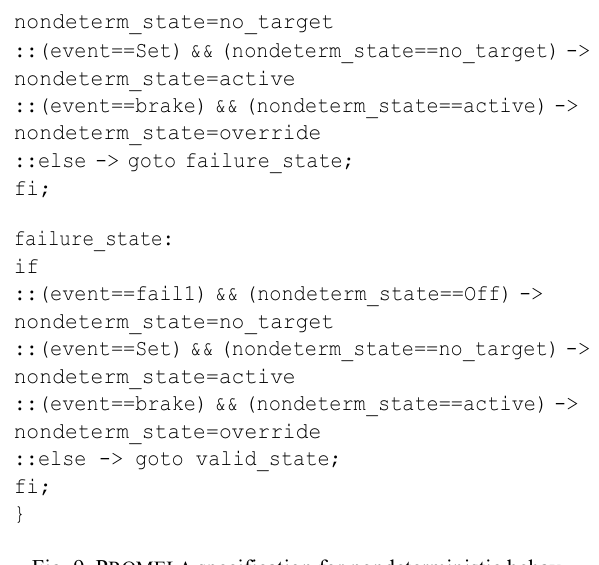
Fig. 9. P ROMELA specification for nondeterministic behav-